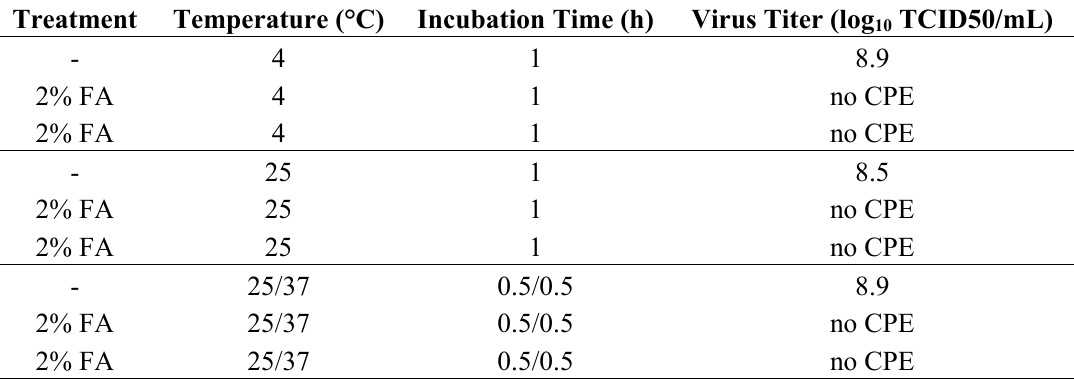
Table 2. Efficiency of Human adenovirus inactivation by formaldehyde at different temperatures. Virus titer was determined by TCID50 assay.